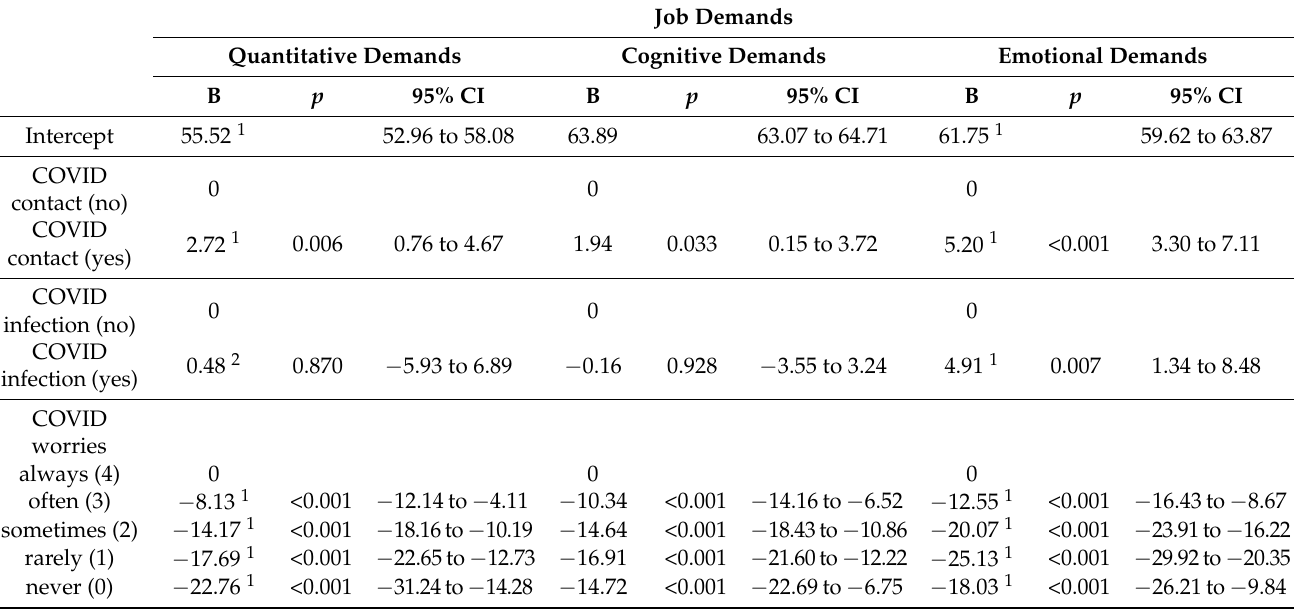
Table 2. Differences between nursing home staff with and without COVID contact or COVID infection and across different levels of COVID worries in job demands. Reference group: COVID contact (no), COVID infection (no), COVID worries (always).